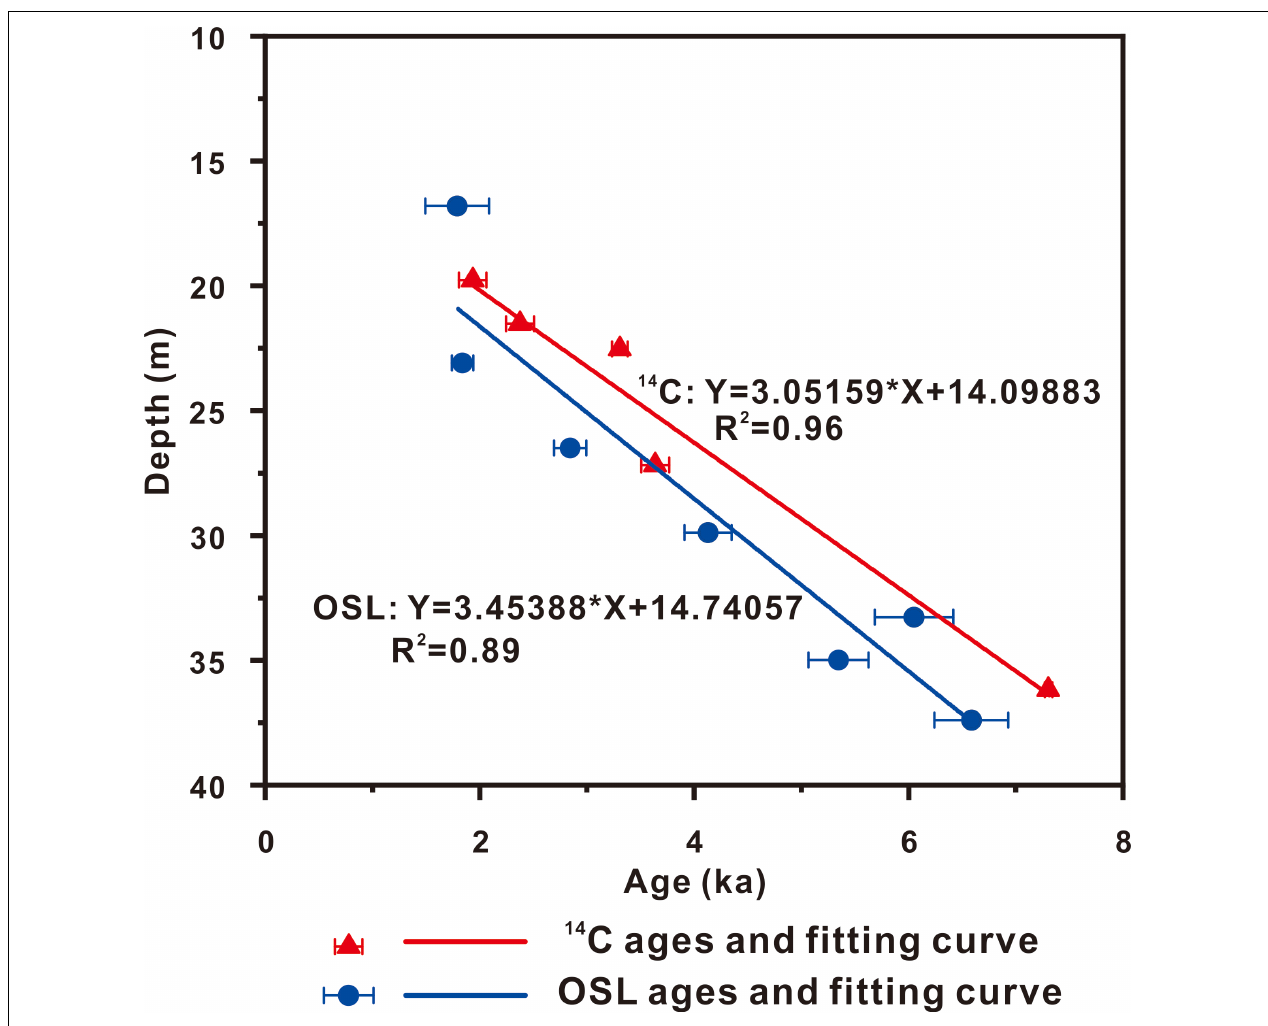
FIGURE 4 | Linear fitting curves for 14 C ages and OSL ages of core DA that obtained from depth 16.8 to 37.4